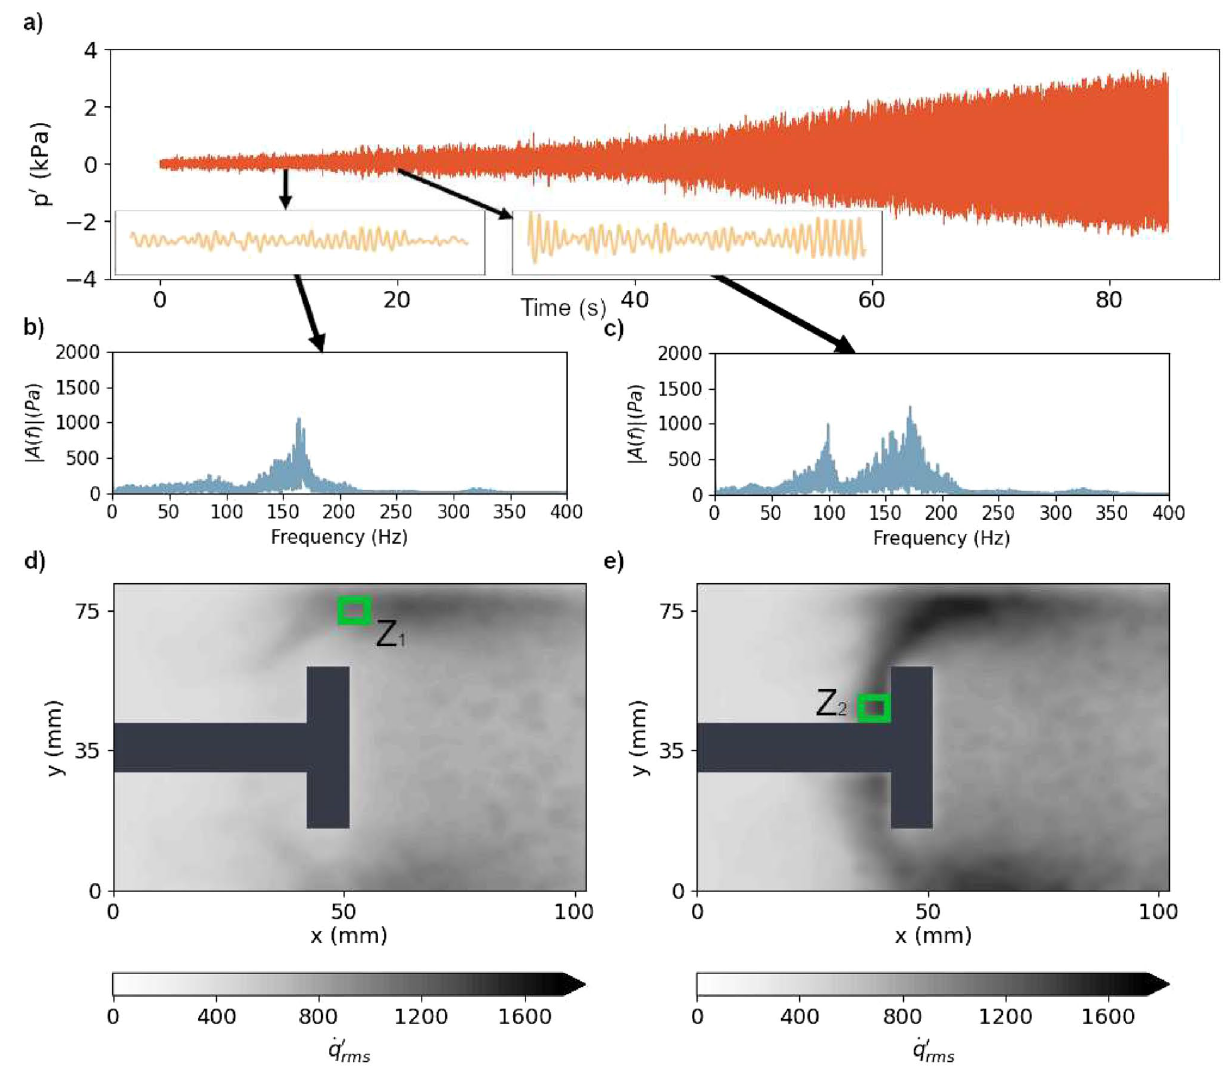
Figure 1. ( a ) Growth of pressure fluctuations from S CN to S TI for the BL bluff body. The insets indicate zoomed-in view of the pressure fluctuations at t = 10 s and 20 s for 0.25 s. The corresponding amplitude spectra obtained from Fast Fourier Transform (FFT) of p ′ from t = 5–15 s ( b ) and from t = 15–25 s ( c ). As the control parameter is varied linearly in time, low-amplitude chaotic fluctuations change to high-amplitude periodic oscillations. At t = 0 s, ˙ m air = 537 SLPM and at t = 80 s, ˙ m air = 777 SLPM. The root mean square ( rms ) of local heat release rate fluctuations ( ˙ q ′ rms ) at t = 10 s ( d ) and at t = 20 s ( e ). The bluff body and its shaft are marked with a black color. The locations Z 1 and Z 2 where high ˙ q ′ rms exist are illustrated by green The growth of pressure fluctuations in turbulent systems is gradual en route to thermoacoustic instability. However, various studies have shown that certain nonlinear measures corresponding to the state variables of the system show an early detection of thermoacoustic instability even before a significant growth in pressure oscillations 23,48,49 . We hypothesize that similar precursory measures of an impending onset of thermoacoustic instability could also be derived from the dynamics of a spatiotemporal variable measured at certain regions in space. Finding such regions may hold the key to identifying spatiotemporal precursors and unravelling passive control strategies that suppress the transition to thermoacoustic instability. To examine the spatial dynamics near the transition, we analyze the spatially resolved local heat release rate fluctuations. Figure 1d,e show the spatial distribution of the root mean square of local heat release rate fluctua- tions ˙ q ′ rms ( x , t ) at mass flow rates of air ˙ m air = 550 SLPM (Fig. 1d) and 650 SLPM (Fig. 1e) respectively for the BL case. The rms is calculated by using one second windows at ˙ m air = 550 SLPM ( t = 4 s) and 650 SLPM ( t = 38 s). Notably, at ˙ m air = 550 SLPM, we observe high ˙ q ′ rms above the bluff body and also at the corner between the bluff body and the shaft. We mark two zones, Z 1 and Z 2 with green squares that represent regions of high ˙ q ′ rms . Z 1 is above the bluff body (Fig. 1d), while Z 2 is at the corner between the bluff body and the shaft (Fig. 1e). The images of instantaneous heat release rate (Fig. S1) near t = 10 s and 20 s support the findings that fluctuations of the